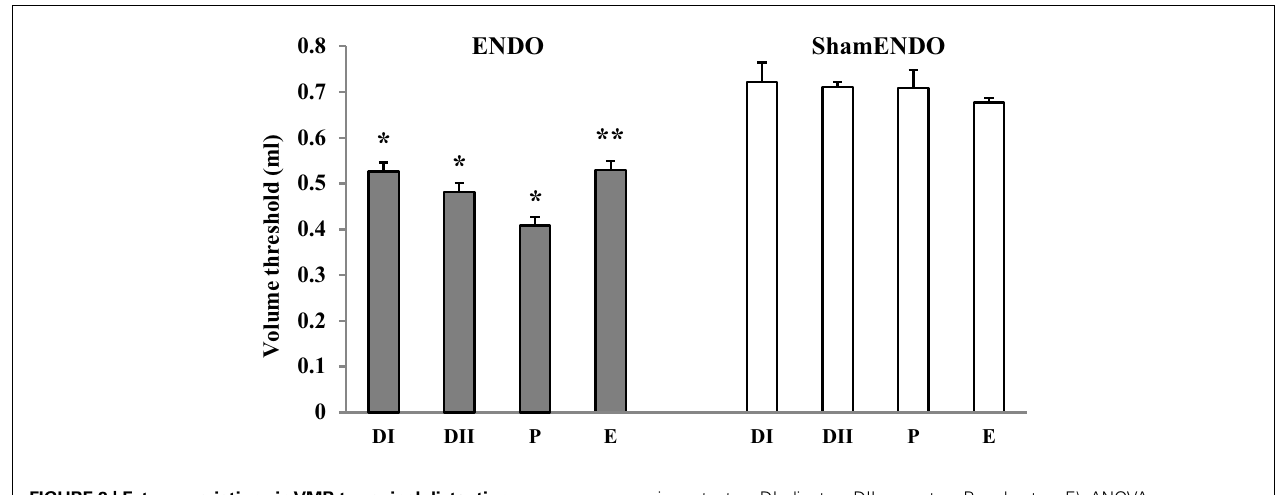
in metestrus DI, diestrus DII, proestrus P, and estrus E). ANOVA showed that thresholds in ENDO rats were significantly different than